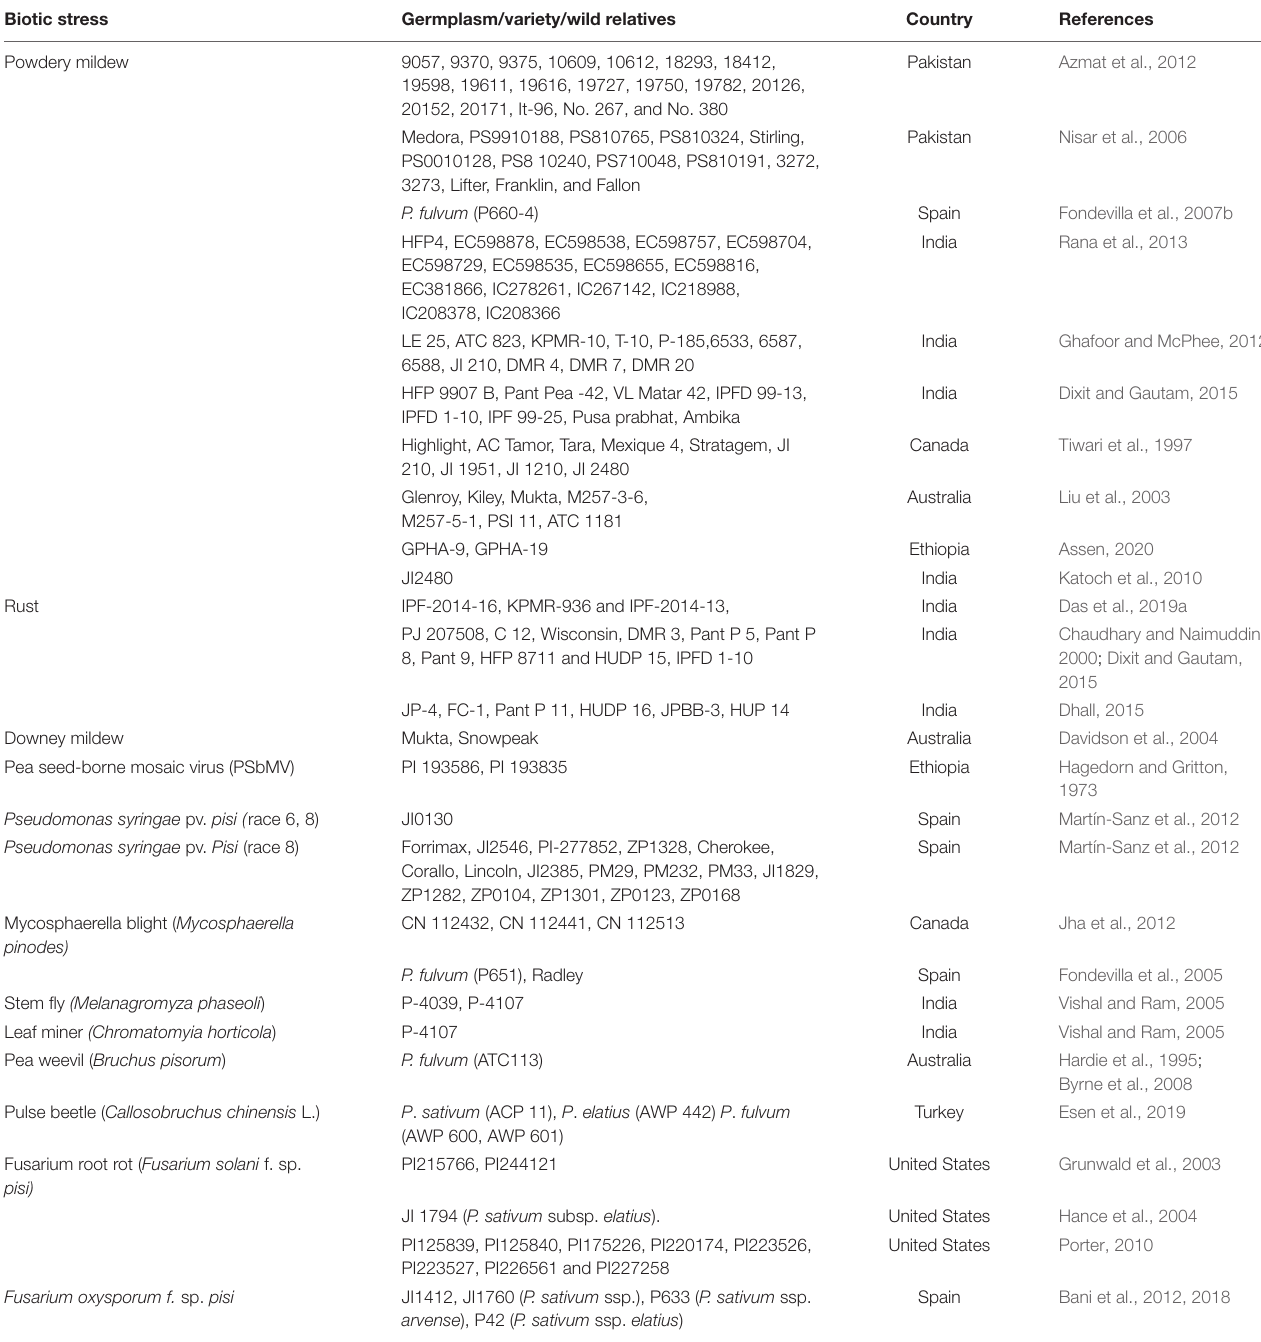
TABLE 1 | Potential resistance source of different biotic stresses in field